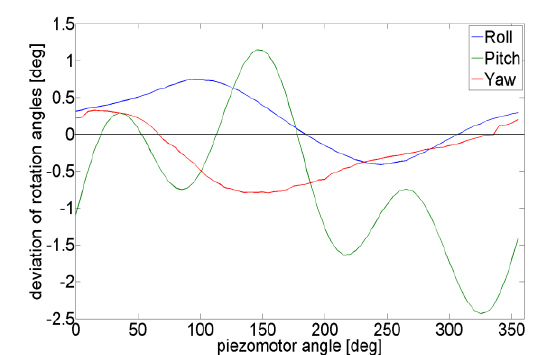
Figure 5. Motion model of tumbling ObCam